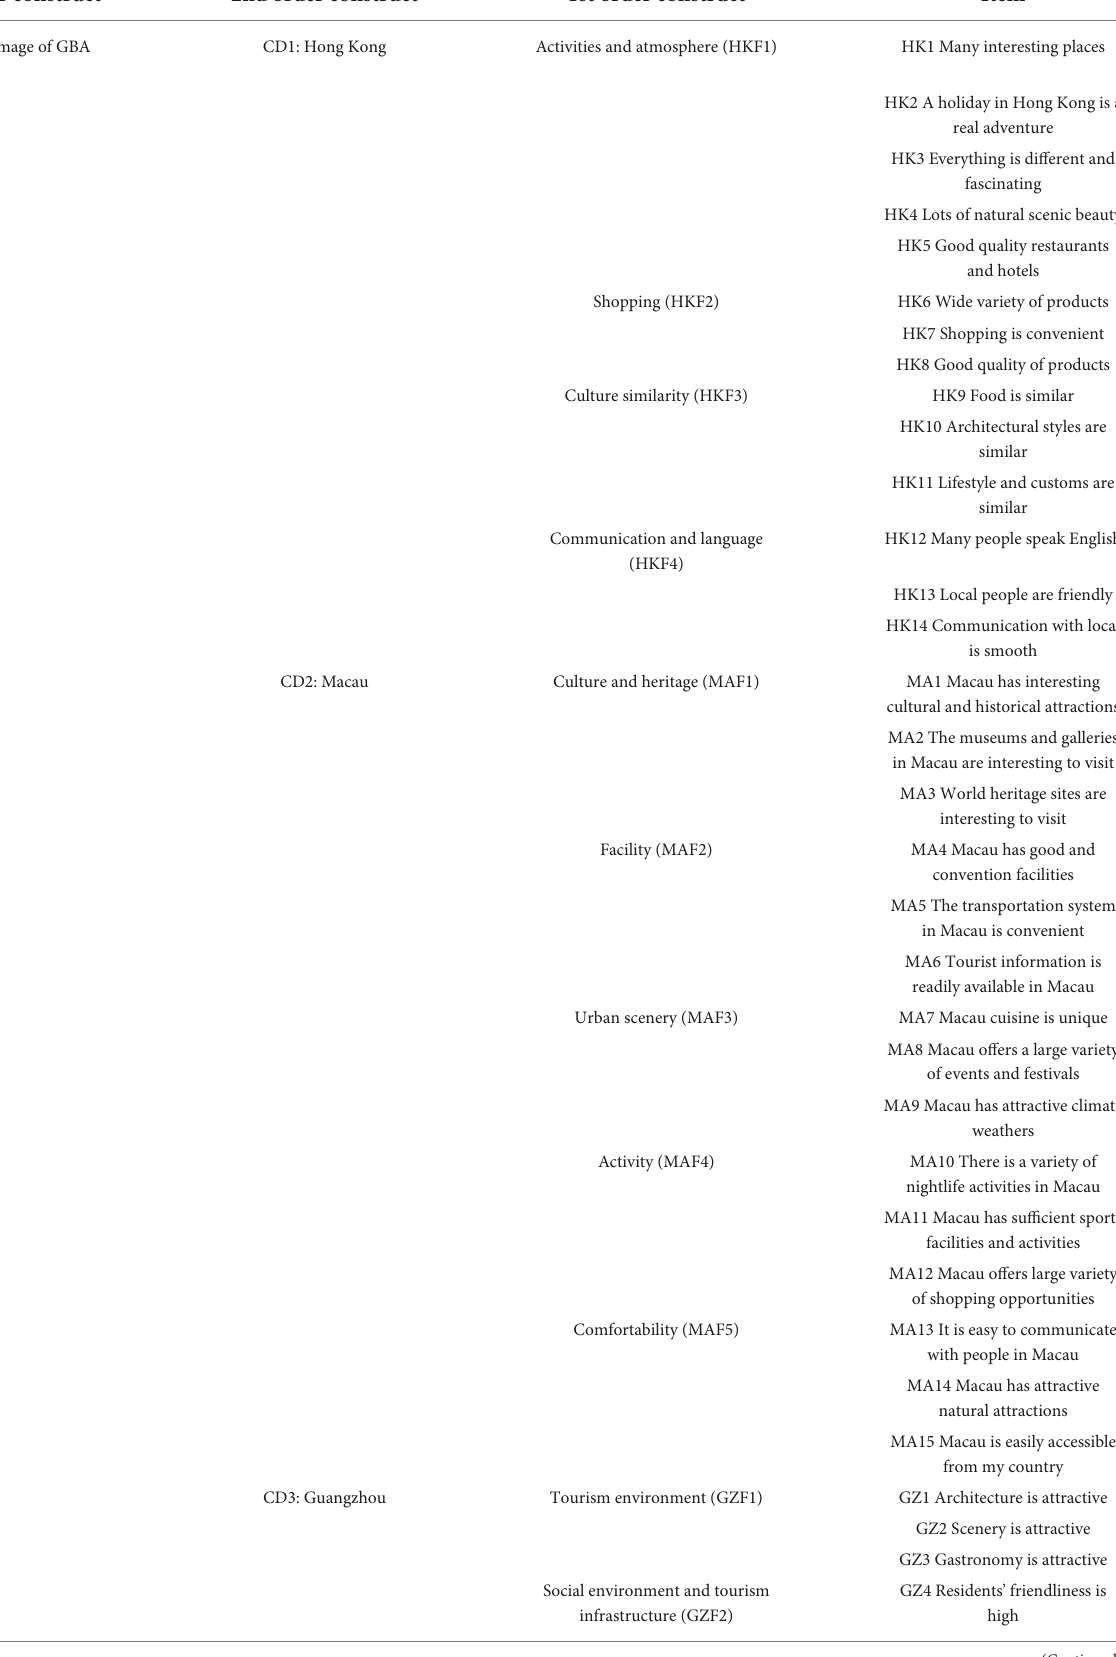
TABLE 1 Measurement